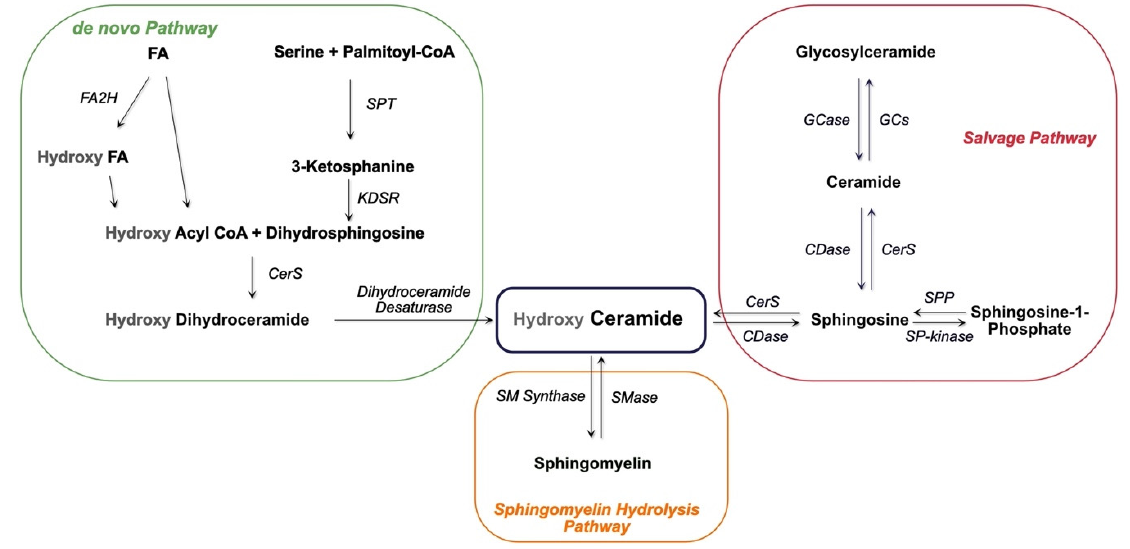
Figure 2. Scheme of ceramide synthesis. Ceramide is synthesized via three distinct pathways, the de novo, the salvage and the sphingomyelin hydrolysis pathways. FA: fatty acid; FA2H: fatty acid 2 hydroxylase; SPT: serine palmitoyl transferase; KDSR: 3-ketosphingosine reductase; CerS: ceramide synthase; GCase: glucocerebrosidase; GCs: glucosyl ceramide synthase; CDase: ceramidase; SP-kinase: sphingosine kinase; SPP: sphingosine-1 phosphatase .